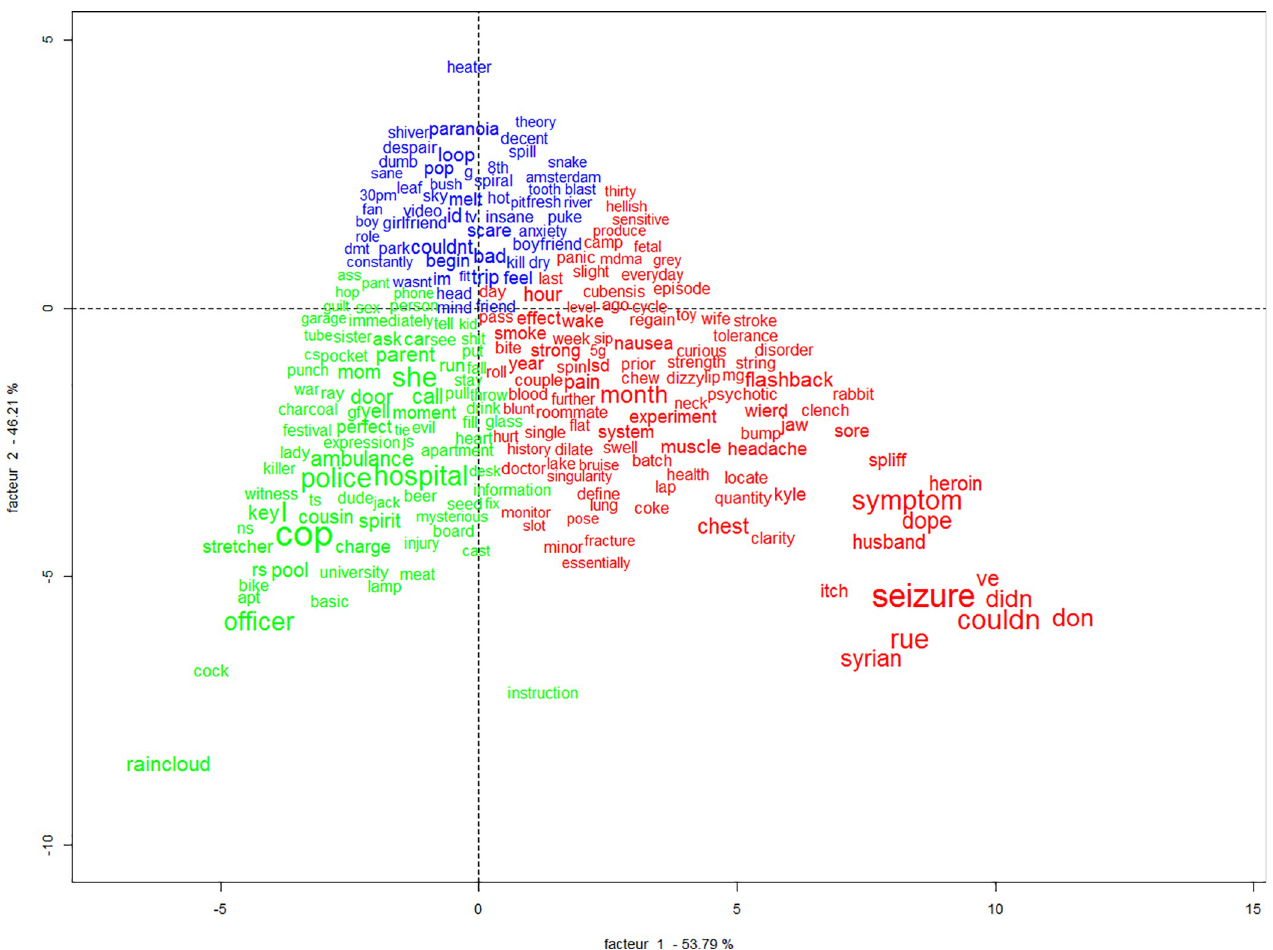
Fig 3. Words relation by cluster and category associated with each cluster. Words in blue belong to Cluster 1 that relates to category 3 (Bad Trips), words in green to Cluster 2 that relates to category 2 (Train Wrecks and Trip Disasters), words in red belong to Cluster 4 that relates to category 1 (Health Problems). Cluster 3 did not relate to any category and is not represented in the